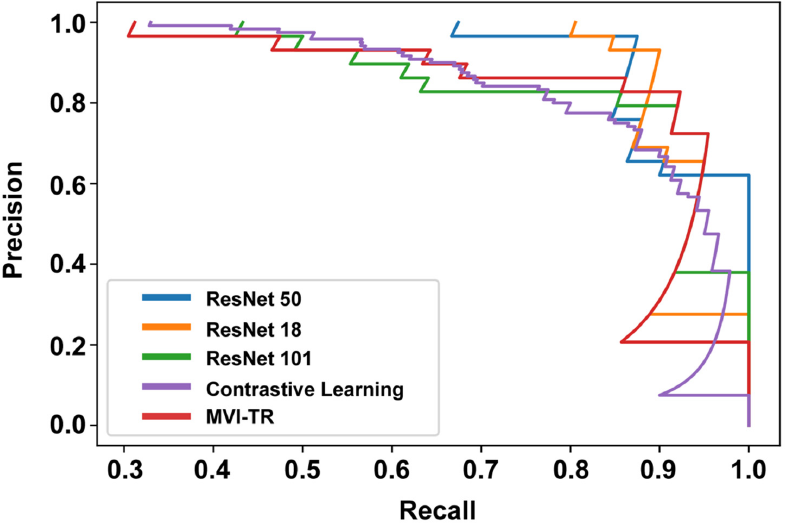
Figure 6. The precision-recall (PR) curves of 5 different models on the validation cohort.